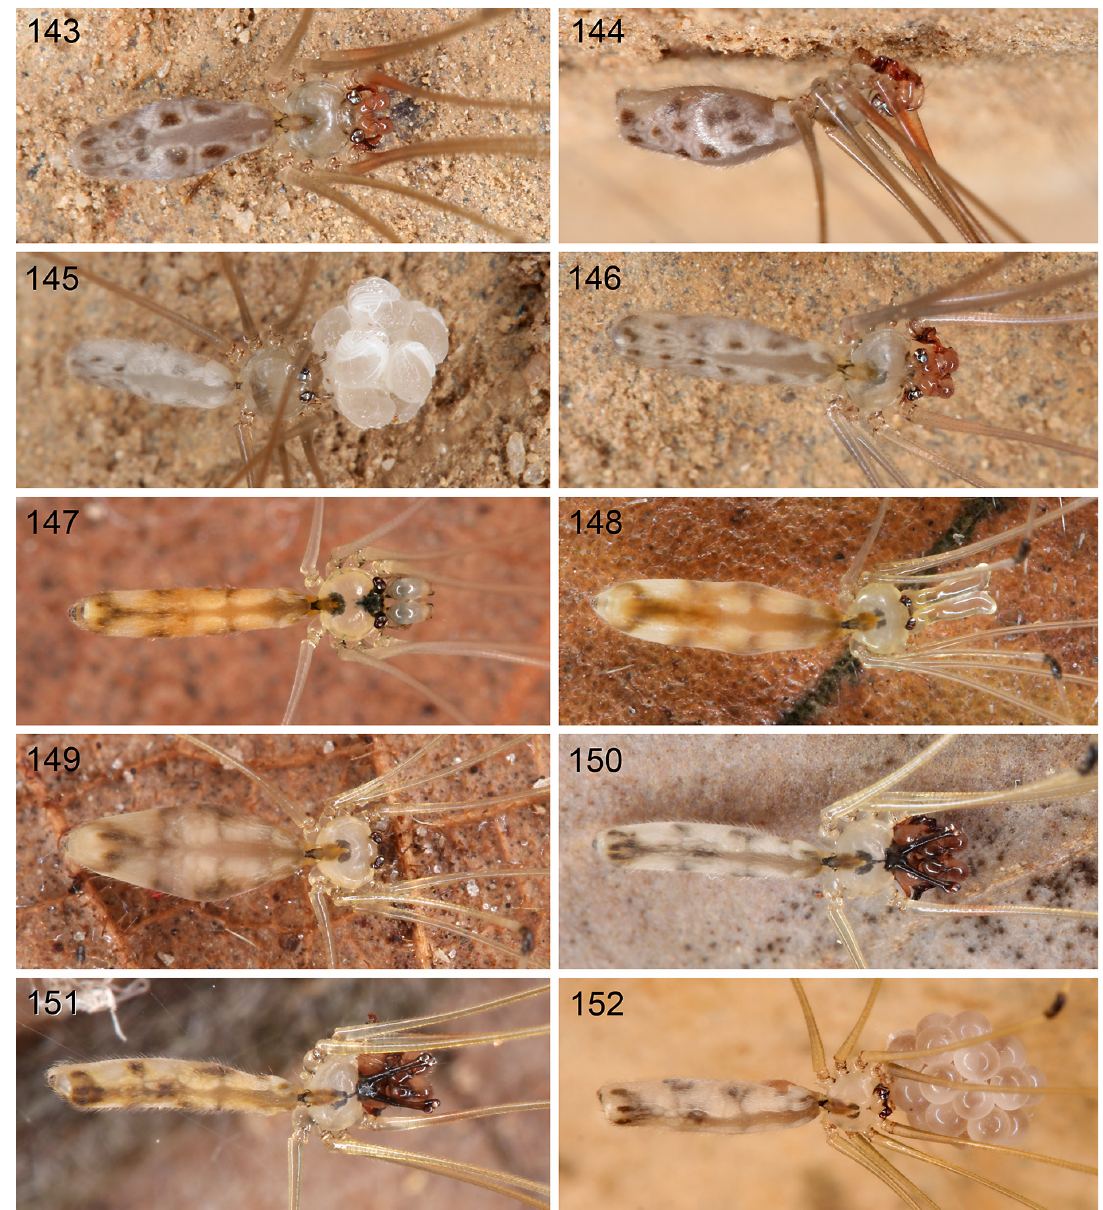
Figs 143–152. Live specimens, Pholcus buatong Huber, sp. nov. (143–146), Ph. satun Huber, 2011 (147–149), and Ph. schwendingeri Huber, 2011 (150–152). 143–145 . ♂♂ and ♀ from Tham Buatong, Thailand. 146 . ♂ from Tham Khao Phueng, Thailand. 147–149 . Adult ♂, penultimate instar ♂, and ♀ from Gunung Jerai, Malaysia. 150–151 . ♂♂ from Khao Sok, Thailand. 152 . ♀ with egg-sac, from Phanom Bencha,